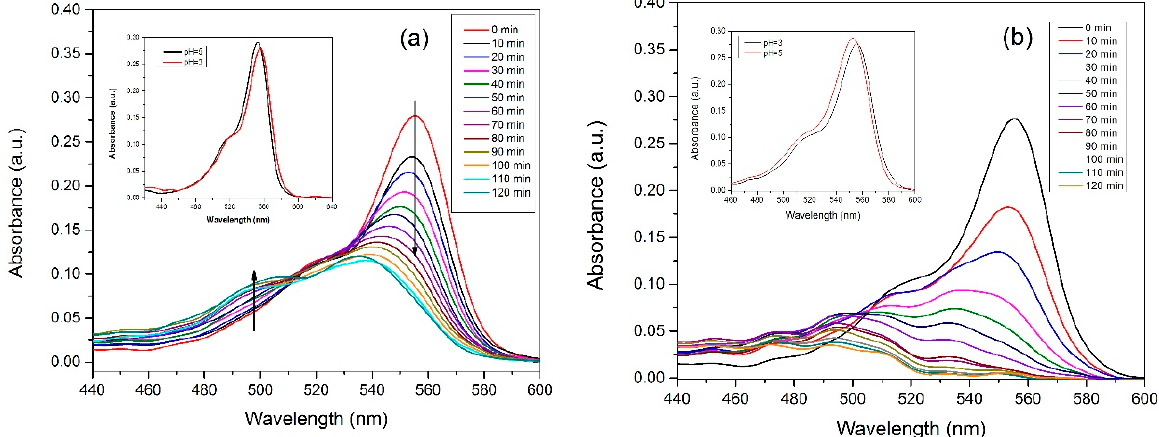
Figure 11. The peak shape evolution of RhB aqueous solution overtime during the reaction of ( a ) catalytic and ( b ) photocatalytic RhB degradation; inset—the redshift of the absorption spectrum for the initial RhB aqueous solution with a variation of the solution pH.